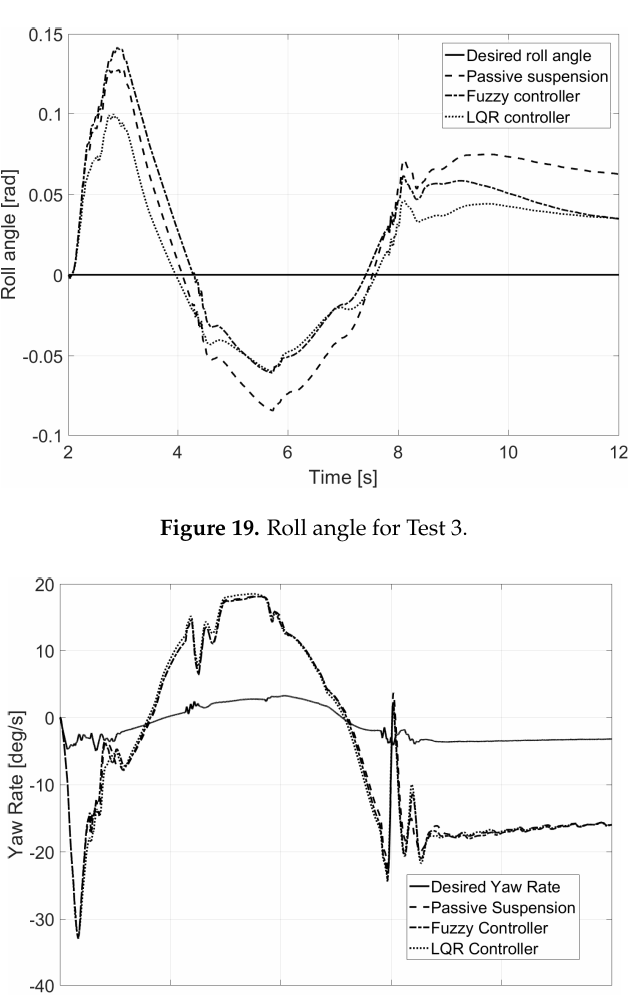
Figure 18. Load transfer coefficient for Test 3.